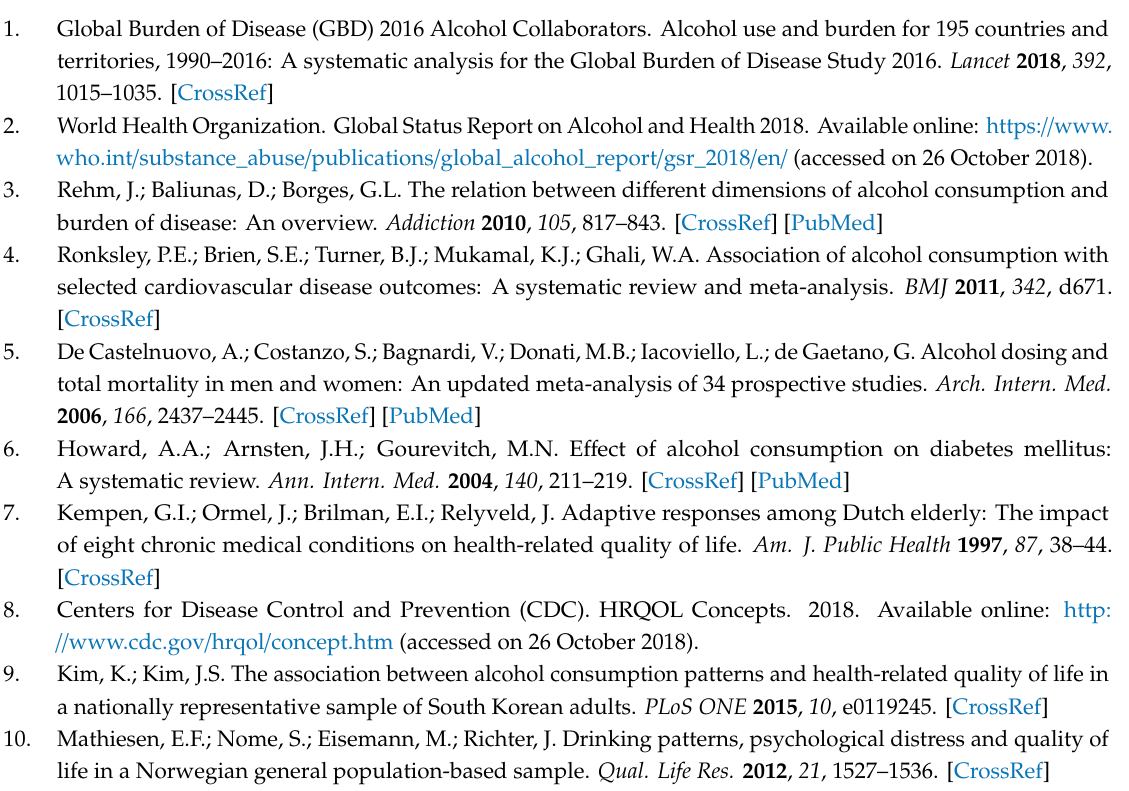
Health-Related Quality of